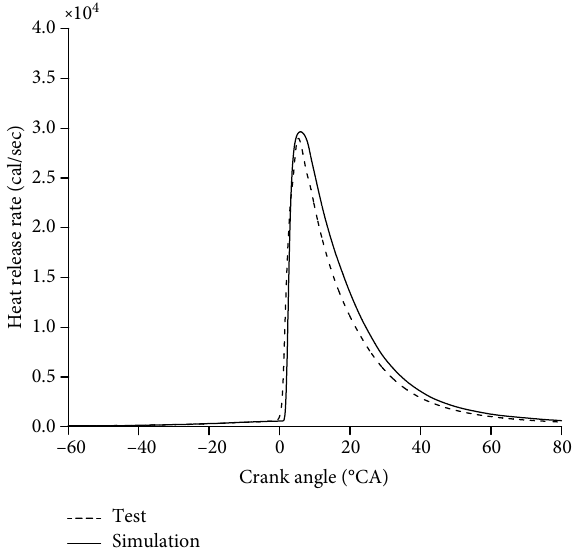
Figure 4: Comparison between simulated and measured heat release rate.